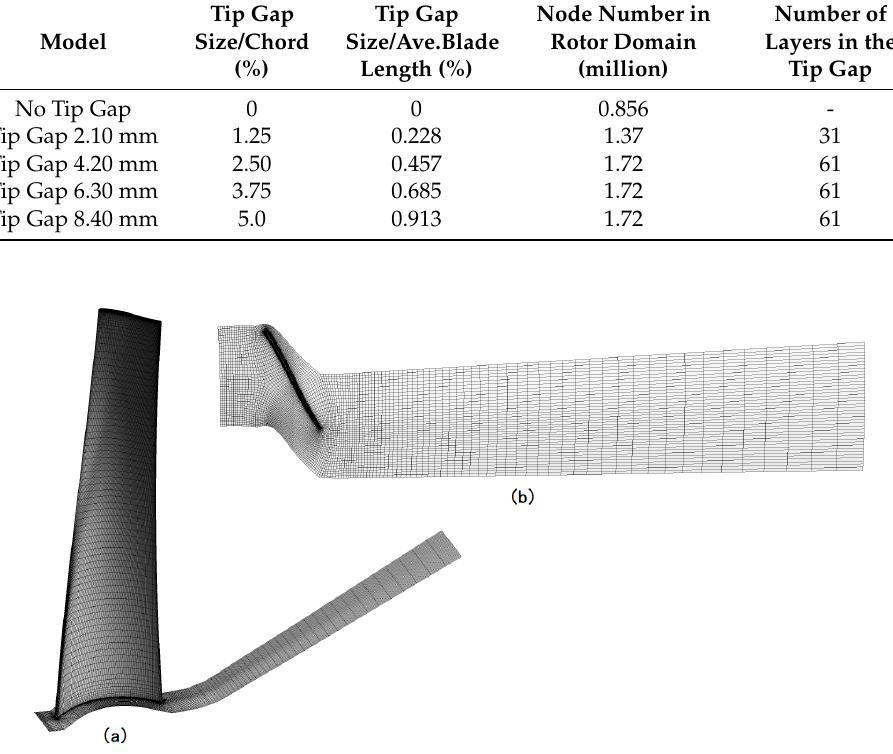
Figure 3. Fluid mesh: ( a ) blade surface and hub and ( b ) blade